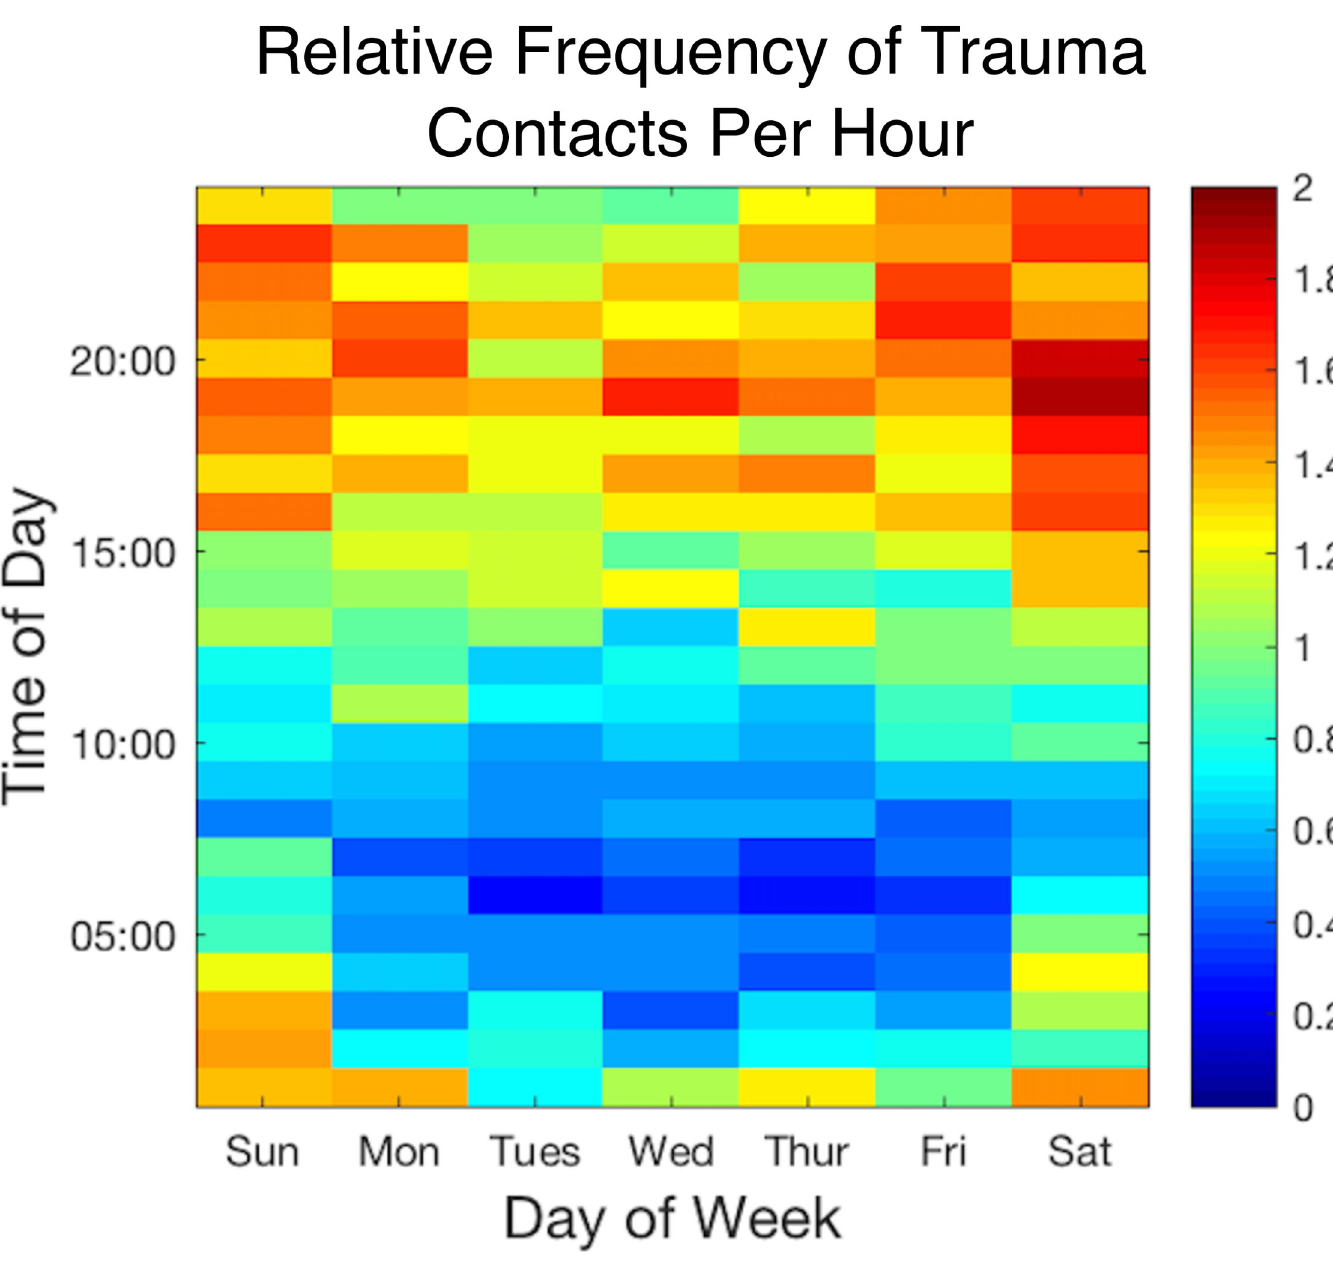
PLOS ONE | https://doi.org/10.1371/journal.pone.0207766 December3,